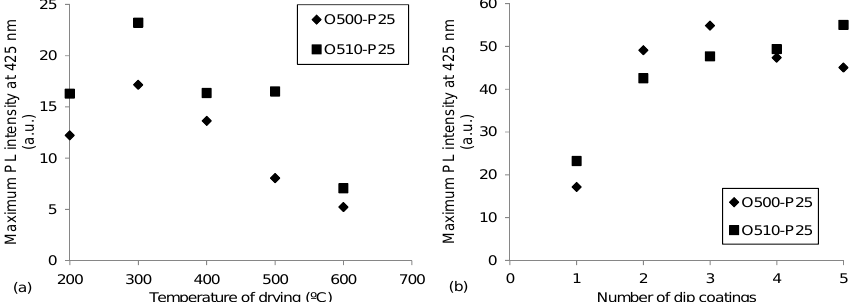
Figure 5. Maximum PL intensity at 425nm for woven meshes coated with O500-P25 and O510-P25 sol solutions as a function of (a) final drying temperature (one dip coating) and (b) number of dip coatings (final drying at T = 300 ◦ C).